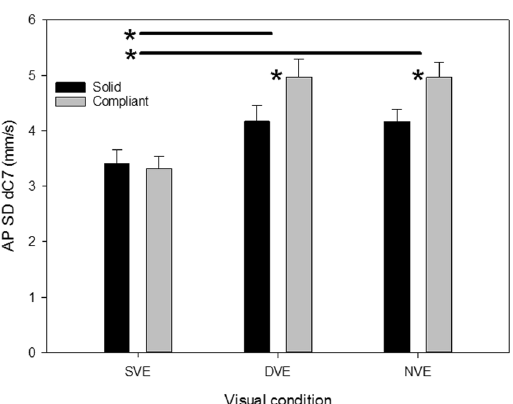
Figure 3. The effect of different visual environments and substrate compliance on antero-posterior (AP) body sway during quiet standing before the mechanical perturbation. Body sway is presented as the standard deviation (SD) of the variability of body sway. SVE: static visual environment; DVE: dynamic visual environment; NVE: No visual environment. * P < 0.05. Horizontal black lines with asterisks indicate significant post-hoc comparisons between visual conditions depicted on the horizontal axis, while single asterisks indicate significant post-hoc comparisons between both surface conditions within a specific visual